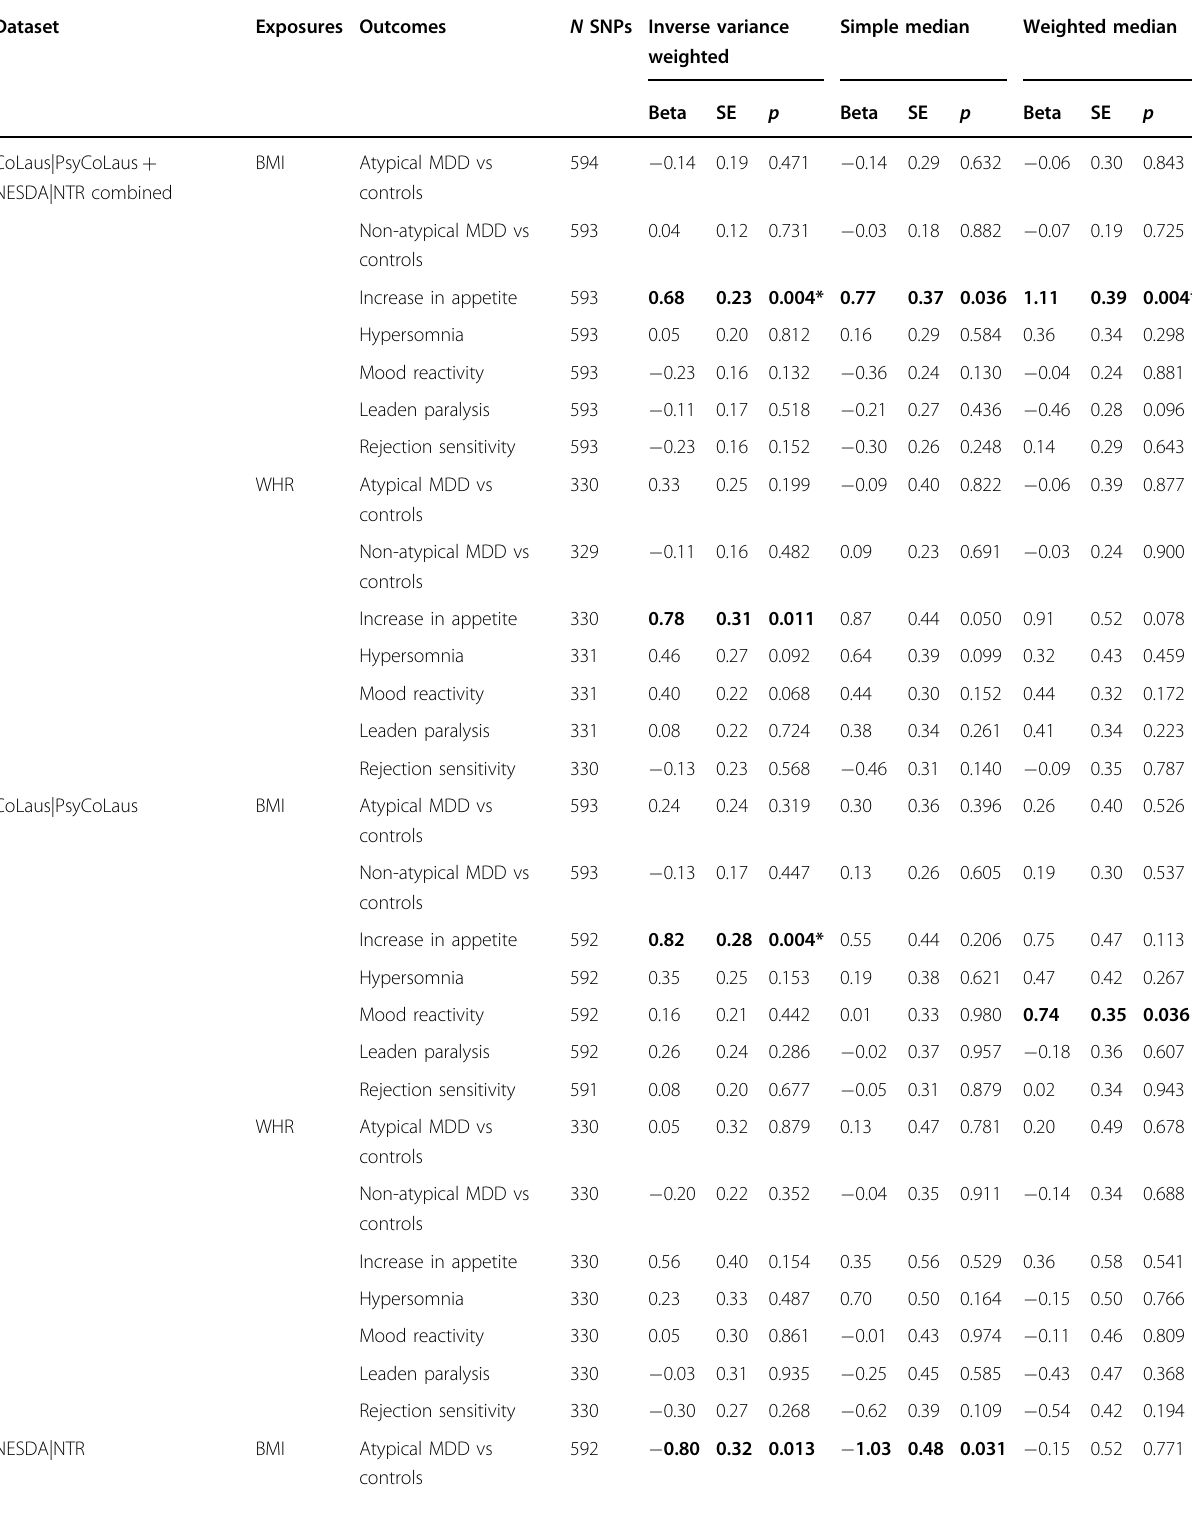
Table 2 Results of the Mendelian Randomization analyses in CoLaus|PsyCoLaus, NESDA|NTR, and in their combined